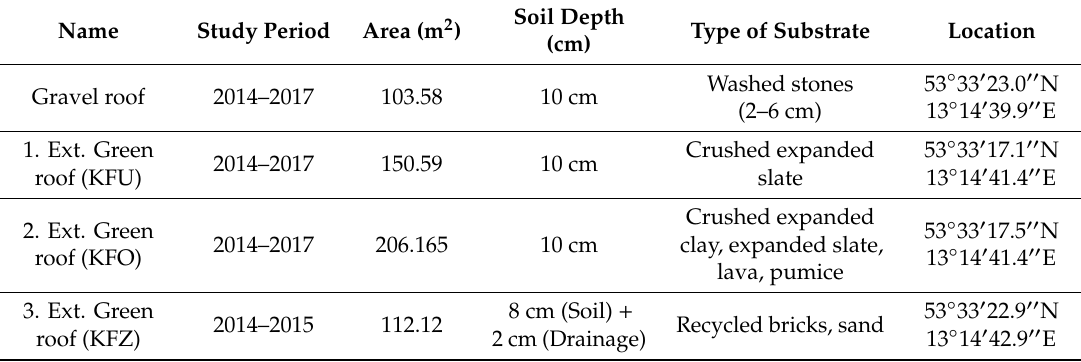
Figure 4. Schematic diagram of the tipping bucket. The volume of the bucket is one liter. The system is fully integrated into buildings 2 and 3 at the University of Applied Sciences in Neubrandenburg, Germany. Four of the systems were installed (3 × green roof, 1 × gravel roof). Table 1. Table of the extensive (Ext.) green roofs and a reference gravel roof for the measurements of water runoff. Every field is equipped with a dipping bucket and is based at the campus of the university on two buildings (No. 2 and No. 3).